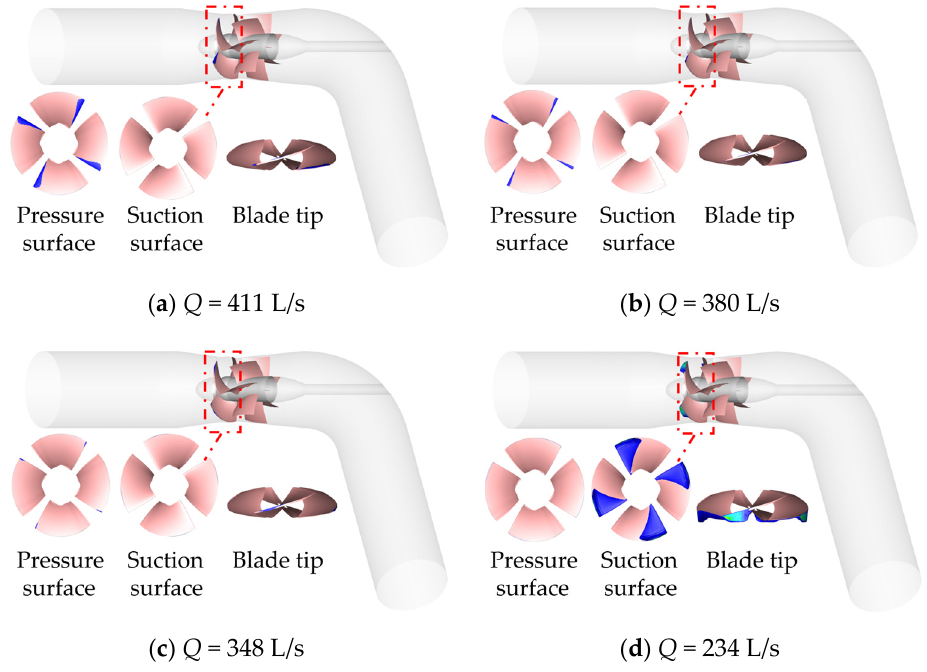
Figure 10. Air bubble distribution volume cloud diagrams at p in = 10 × 10 4 Pa.